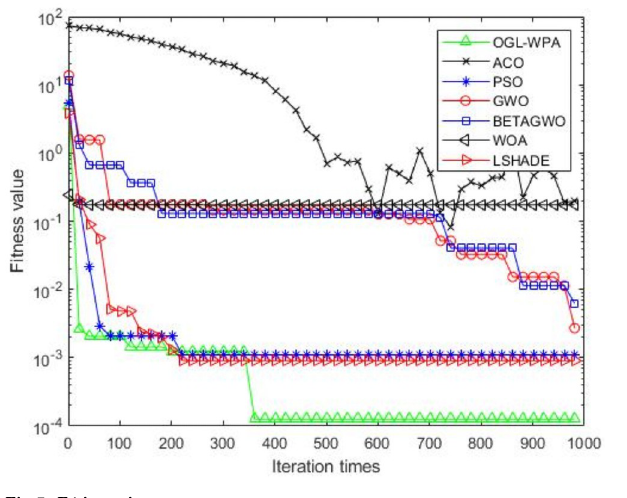
Fig 5. F4 iteration